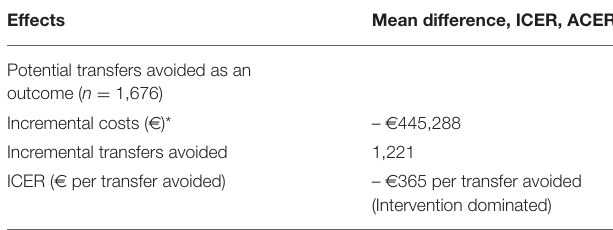
TABLE 3 | Cost-effectiveness analysis